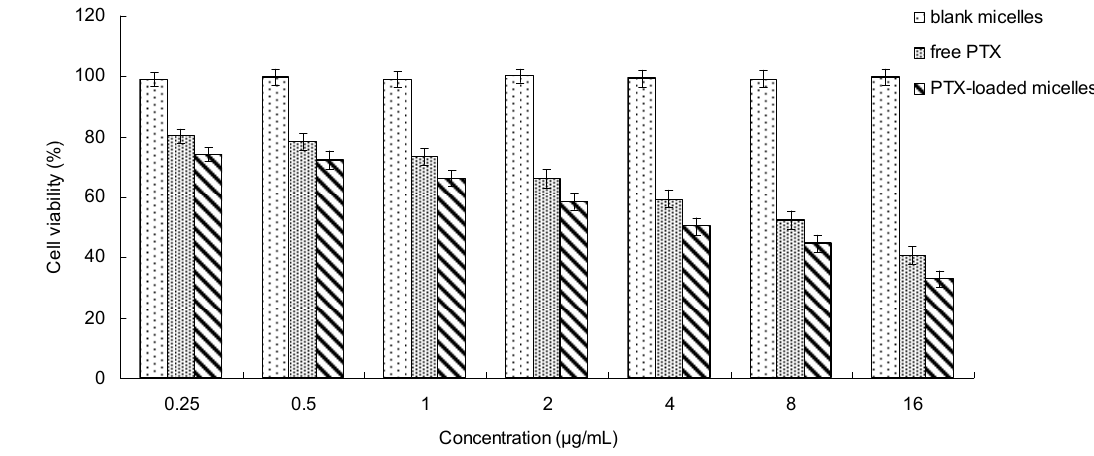
Figure 7. In vitro cytotoxicity of PTX-loaded FA-CS-DA micelles.